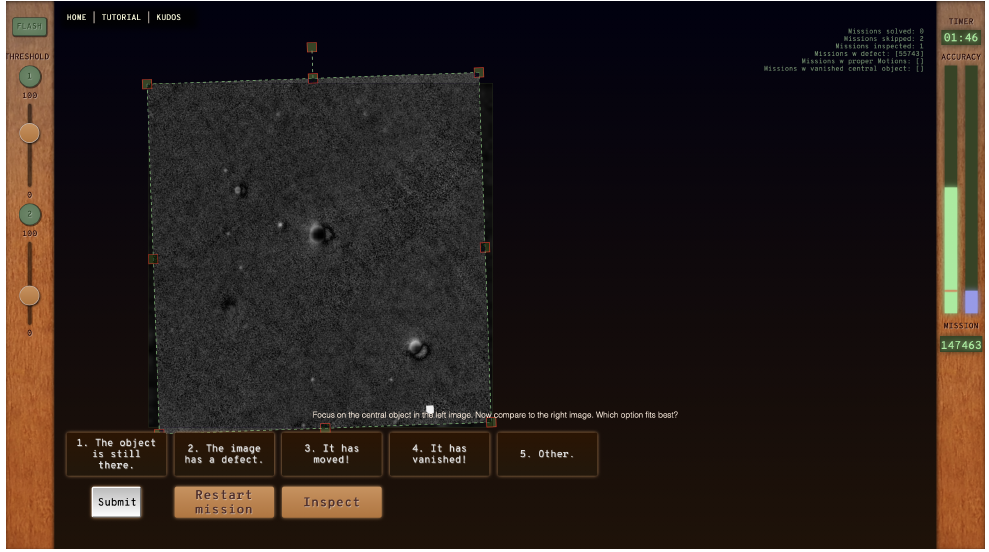
Figure 5. An example of two matched images. The matching of the user results in a high accuracy (green bar), better than that given by the AI (purple